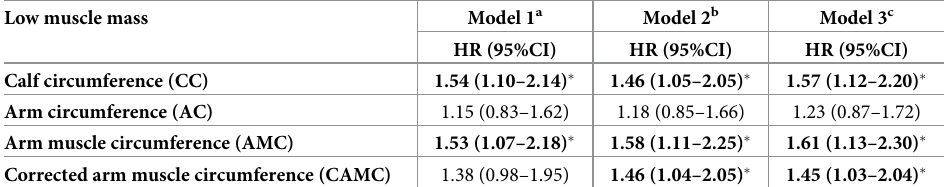
Table 4. Fully adjusted Cox proportional risk analysis to assess the association of low muscle mass according to anthropometric measures with all-cause mortality (n =